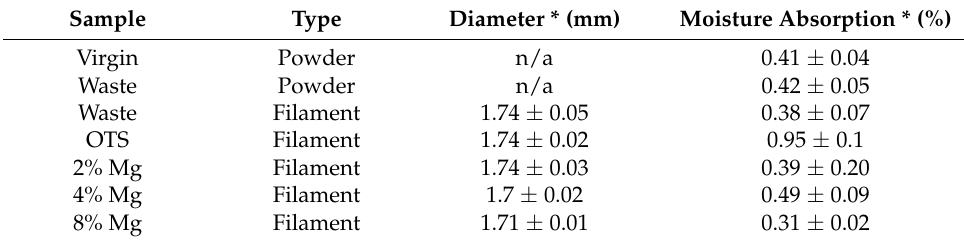
Table 1. Filament diameter and moisture absorption.